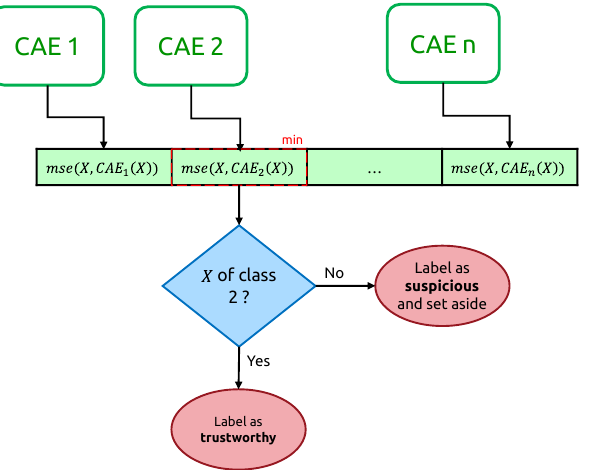
Figure 8. Illustration of a vector of Mean-Squarred errors, used to identify suspicious and non- suspicious time